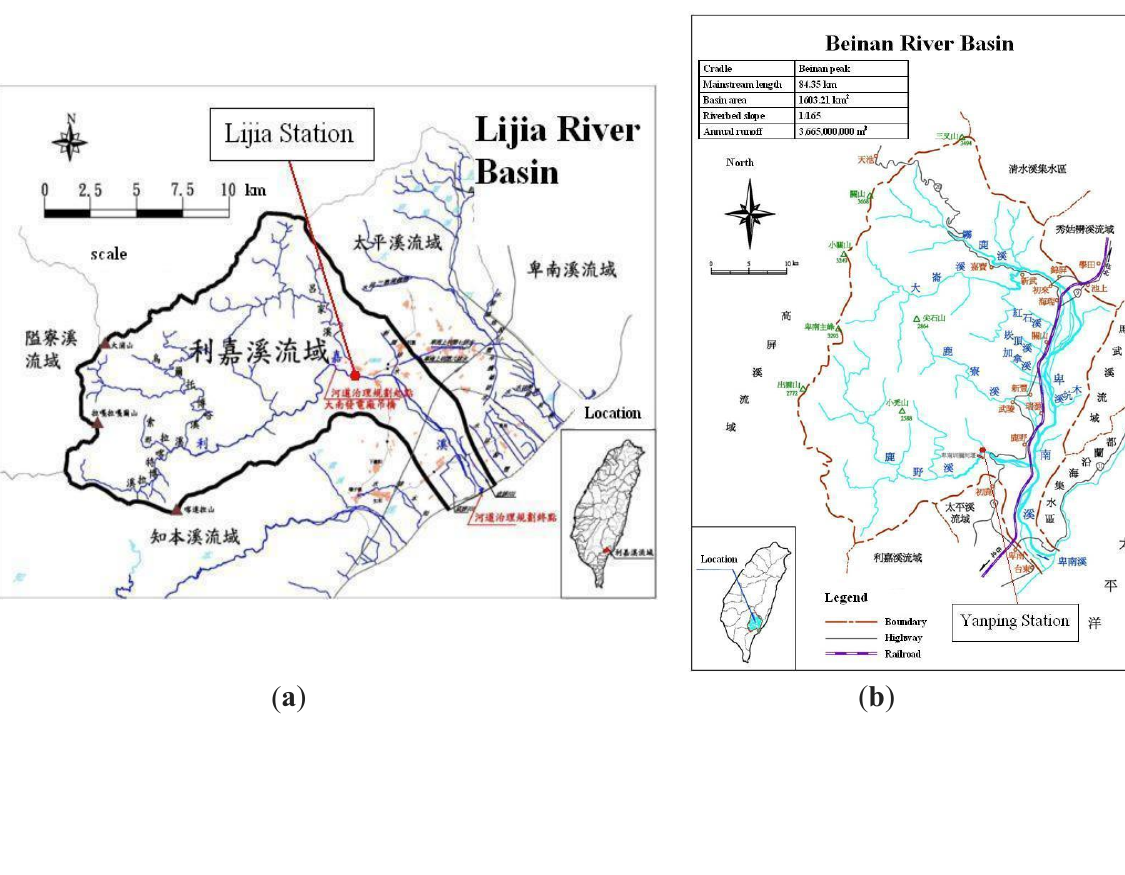
Figure 2. The location of the six investigated hydrometric sites in eastern Taiwan. The boundaries of the drainage basins are also shown [25]. ( a ) Lijia Station; ( b ) Yanping Station; ( c ) Tateyama and Mizuho Bridge Station; ( d ) Renshou Bridge and Hualien Bridge